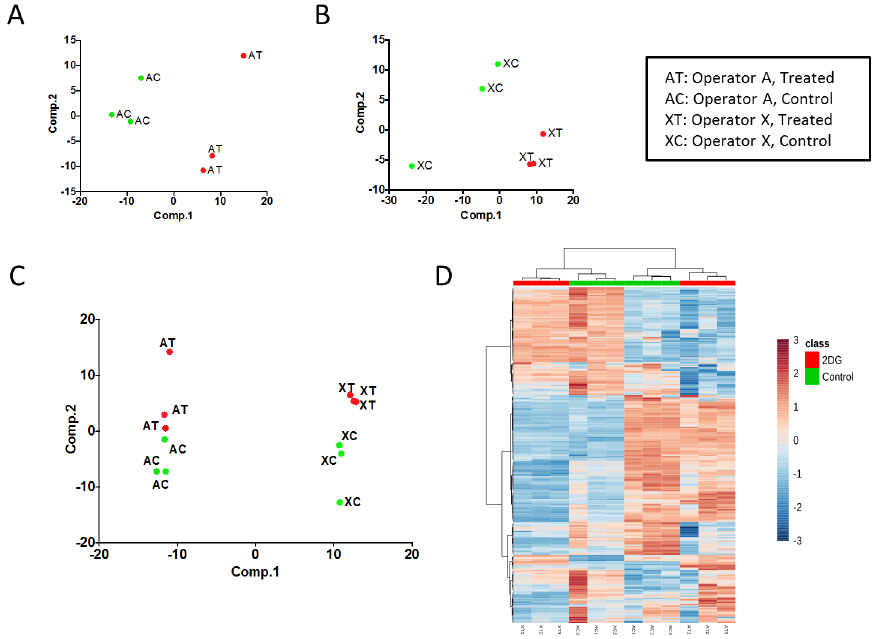
Fig 1. Description of the biological effectsand batch effectsin the metabolomics dataset used in this